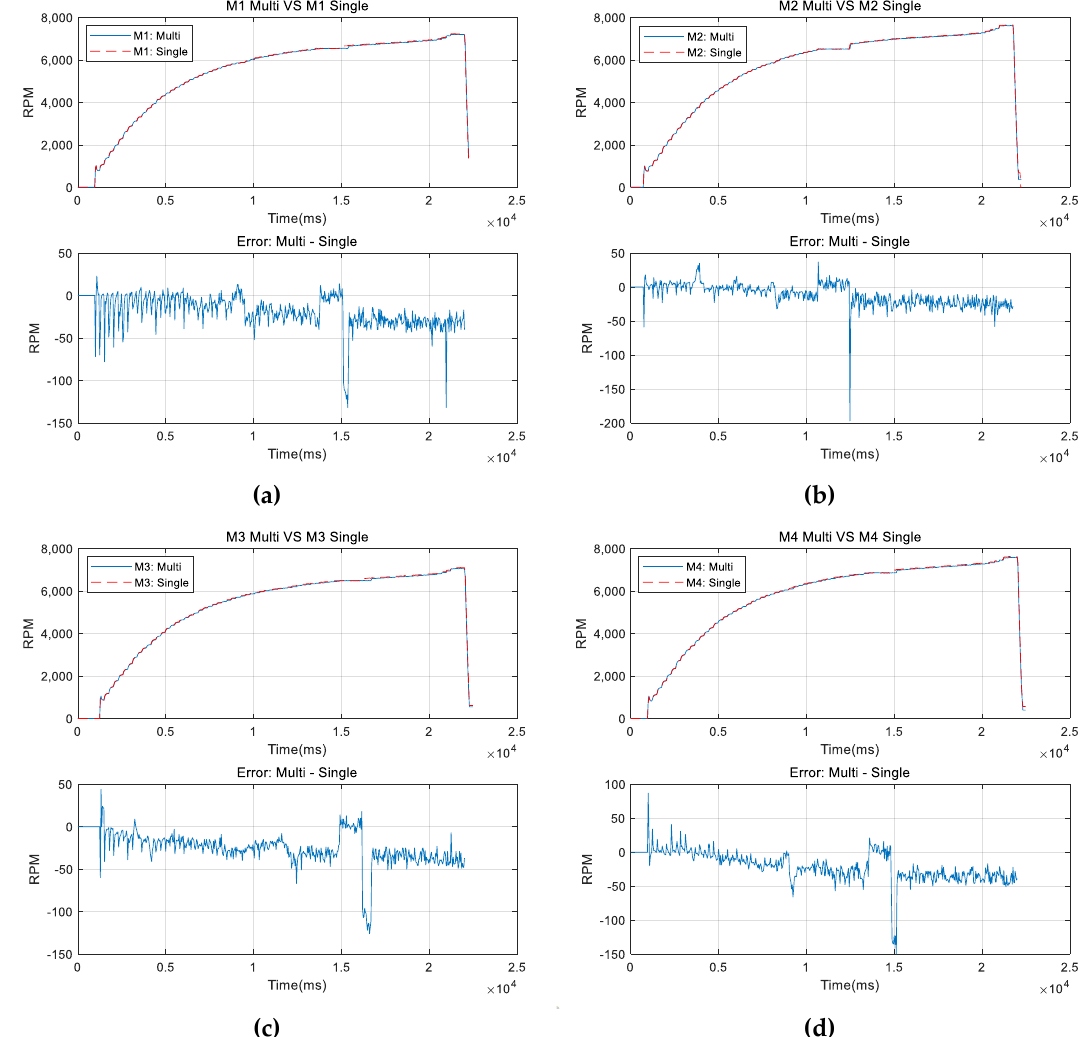
Figure 9. The Experiment B result of motor speed response to changing control signals when only one motor drives. ( a ) M1: single driven vs. multi driven; ( b ) M2: single motor vs. multi motors; ( c ) M3: single motor vs. multi motors; ( d ) M4: single motor vs. multi motors.